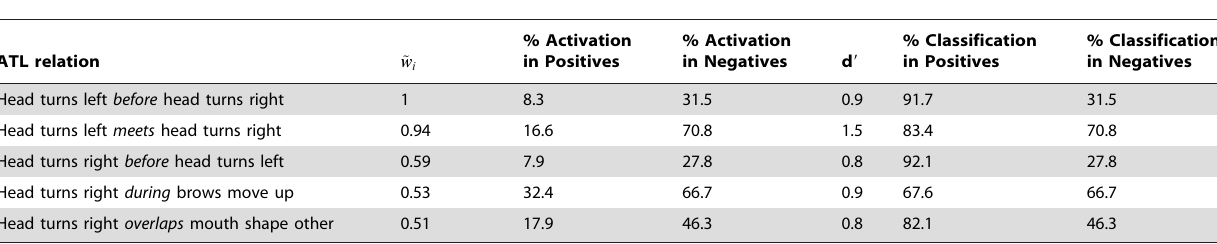
Table 8. Discriminant features for polarity in Hypothetical conditionals.